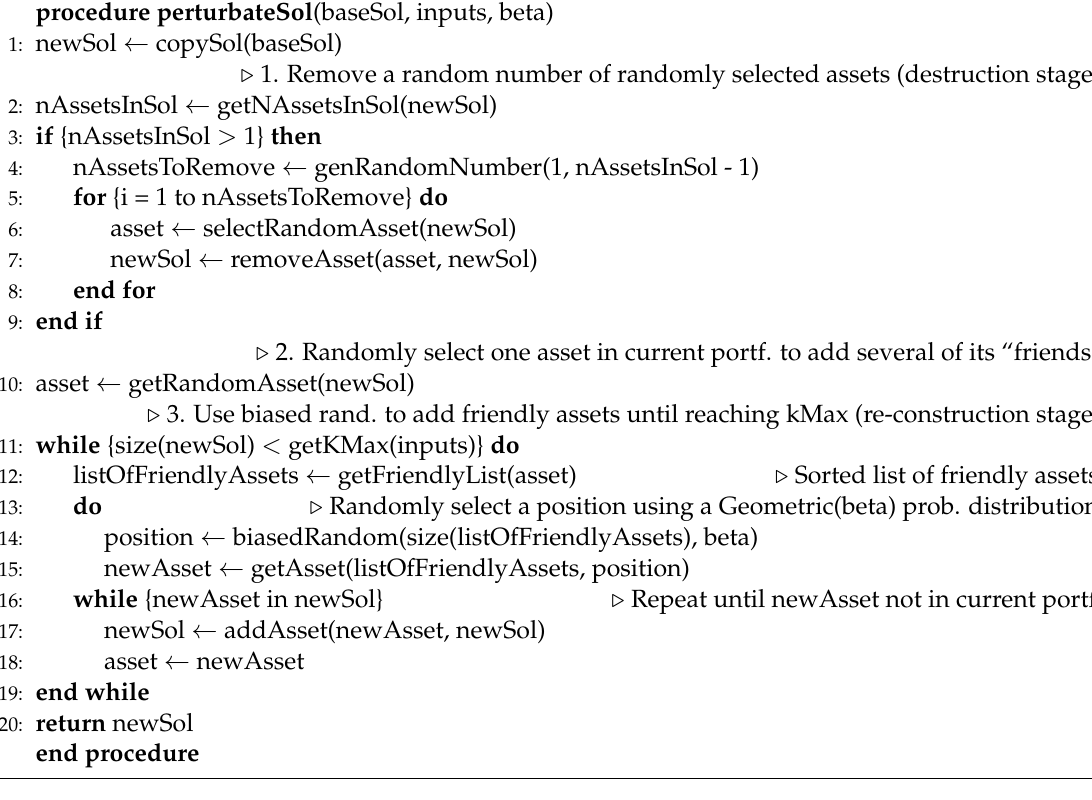
Algorithm 3 Repair procedure to make newly generated solutions feasible. procedure repairSolution (sol,